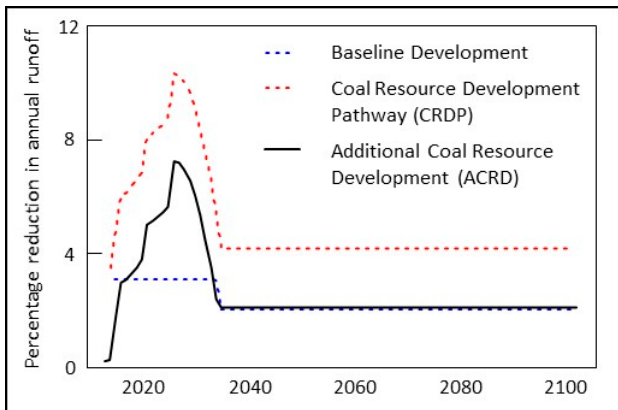
Figure 2. Reduction in annual runoff at Node 14 from coal mine footprint.